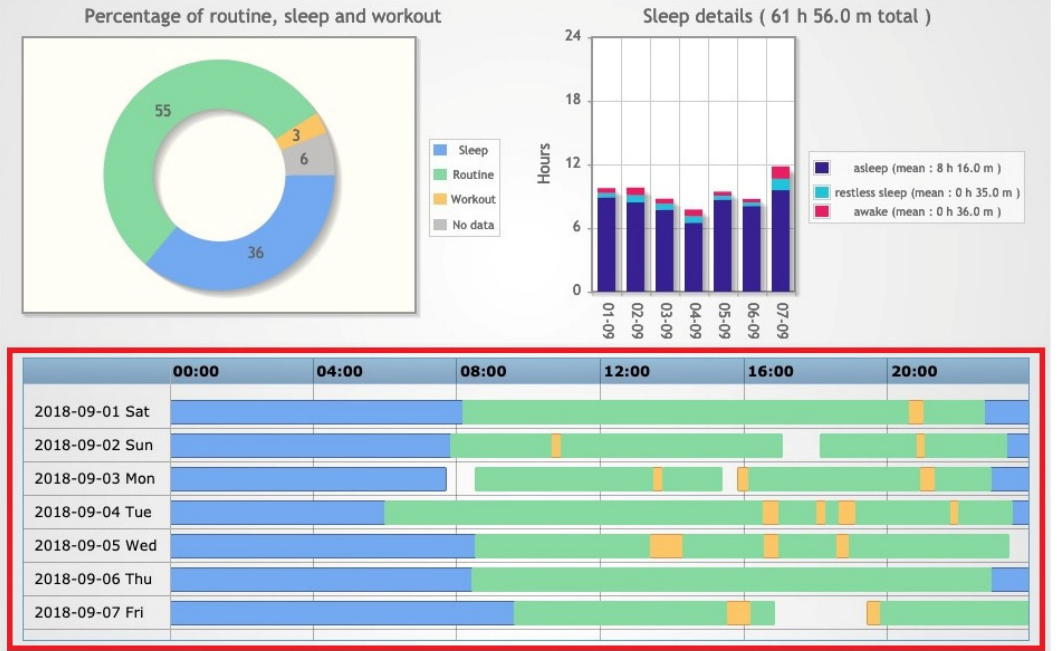
Figure 7. Example of a subject’s Lifestyle summary recorded during holidays.